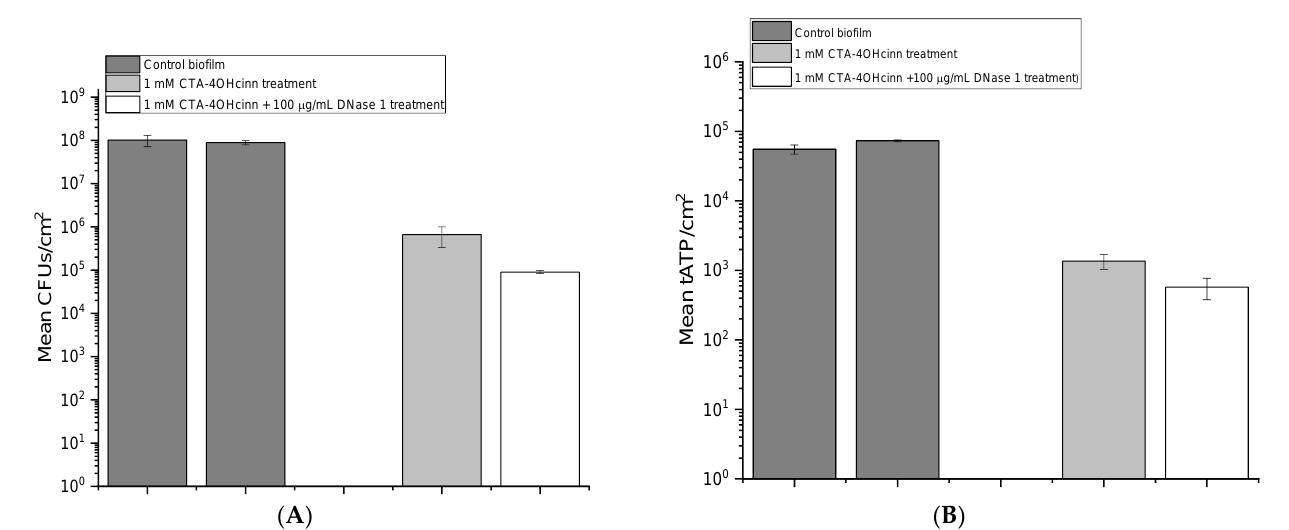
Figure 5. Biofilm viability assay colony forming units (CFUs; A ) and total adenosine triphosphate (tATP; B ) assays of control ( ), 1 mM CTA-4OHcinn ( ) and 1 mM 1 mM CTA-4OHcinn + DNase ). 1 enzyme ( ). Each bar represents measurements taken from triplicate biofilms with two technical replicates. Error bars represent the standard deviation of this data.